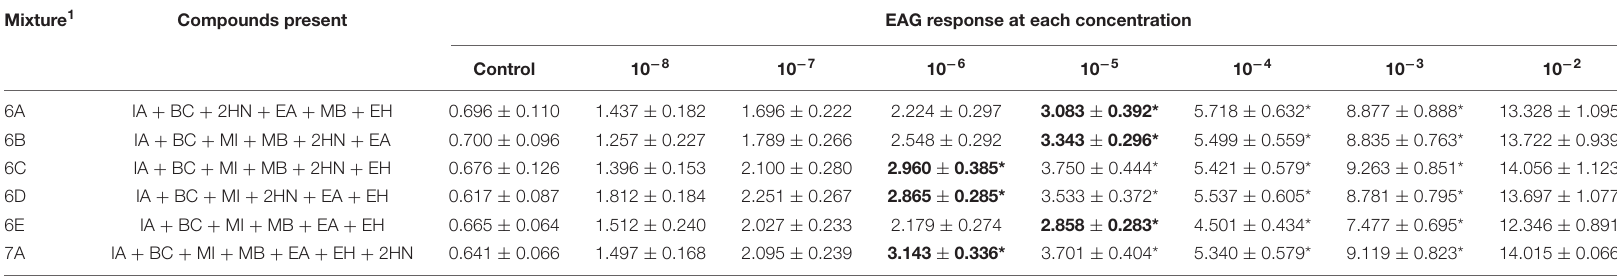
TABLE 7 | Electroantennogram (EAG) responses (mean ± SEM) of female D. suzukii to different concentrations of mixtures with 6-7 compounds. Mixture 1